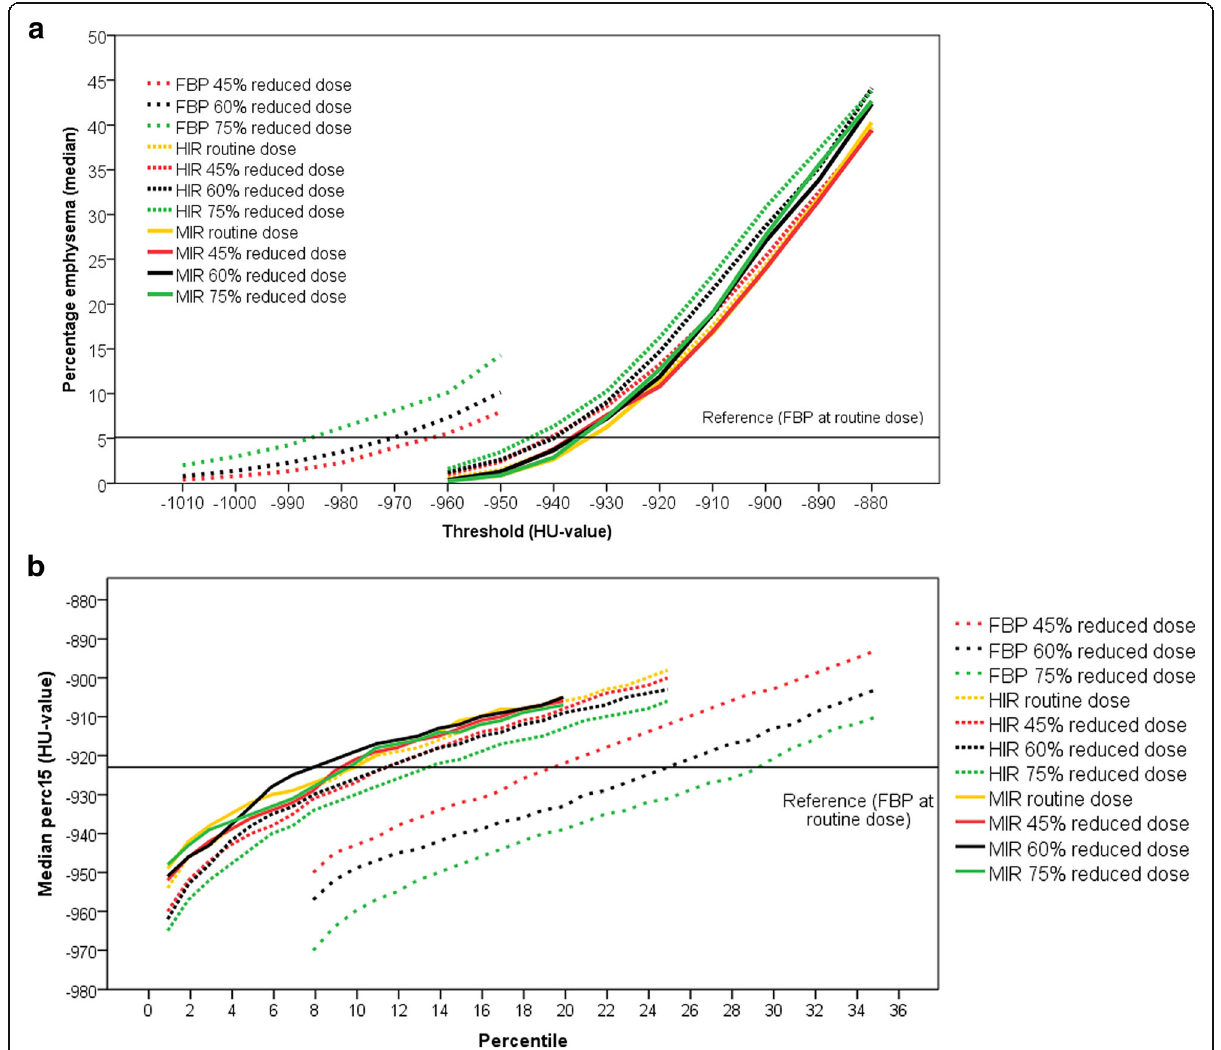
Fig. 4 Effect of different thresholds ( a ) and percentiles ( b ) on emphysema quantification. For FBP at reduced dose a lower threshold is more appropriate, while with HIR and MIR a higher HU threshold should be used. With the percentile quantification method, FBP at reduced dose requires a higher percentile while with HIR and MIR a lower percentile should be used to achieve the same results as with FBP at routine dose. FBP filtered